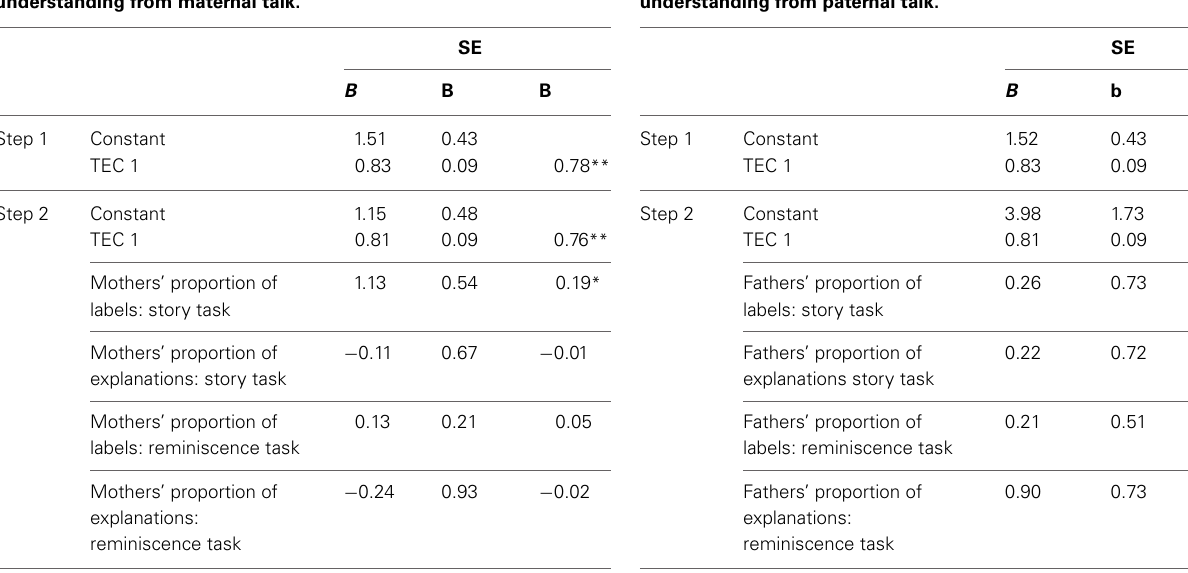
Table 5 | Regression model predicting children’s emotion understanding from paternal